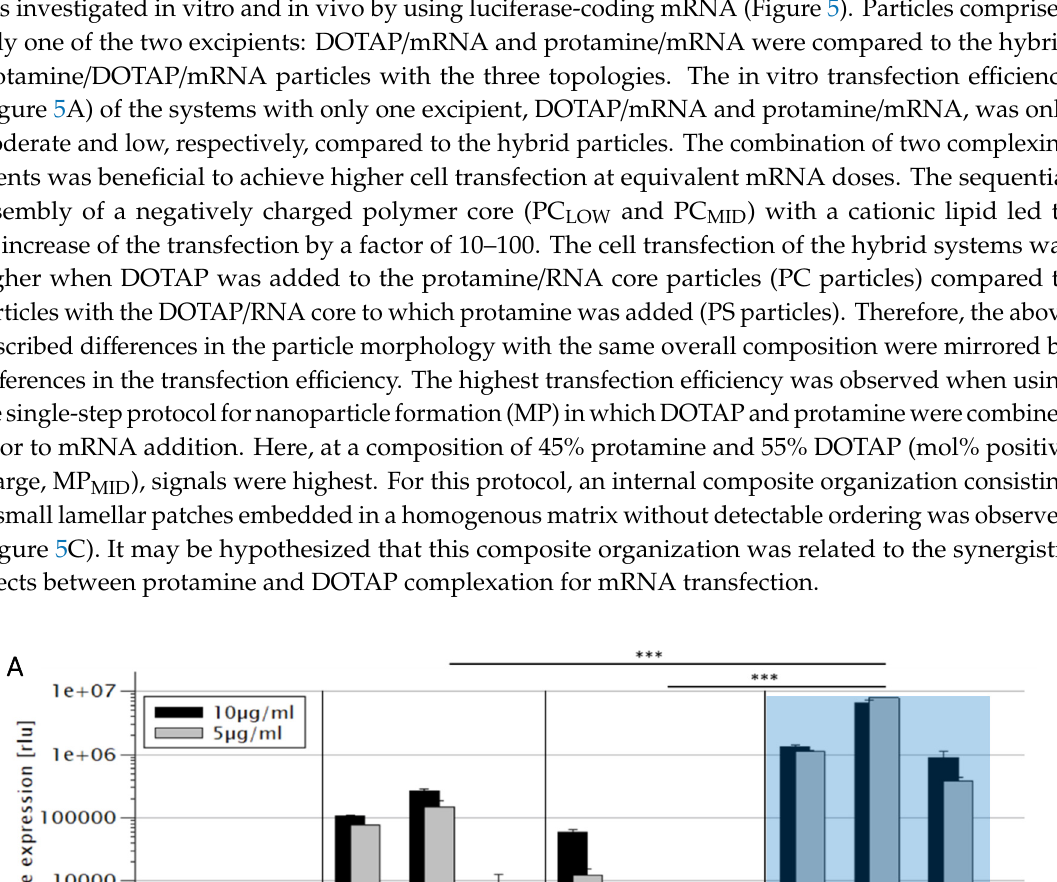
Figure 5. ( A ) HEK293 cell transfection of different protamine/DOTAP hybrid nanoparticles at different compositions in comparison to protamine/mRNA and DOTAP/mRNA particles. *** p < 0.001. Statistical significance was determined using two-way ANOVA combined with a Bonferroni comparison test. ( B ) Bioluminescence imaging of mice ( n = 3 for particles, n = 2 for negative control) 6, 24, and 48 h after i.m. injection in the footpad of PC MID , PS MID , MP MID , protamine/mRNA, DOTAP/mRNA or only PBS buffer (not shown). The average radiance is quantified as photons/sec/cm2/sr, meaning the amount of photons that are emitted per second per square centimeter tissue per square radian (solid angle). ( C ) Total flux kinetic analysis of the samples with respect to time. ( D ) Cumulative bioluminescence signal intensity at all time points indicating protein expression following injection of the respective samples. ** p < 0.01. Statistical analysis was performed using one-way ANOVA with Tukey’s multiple comparisons test.